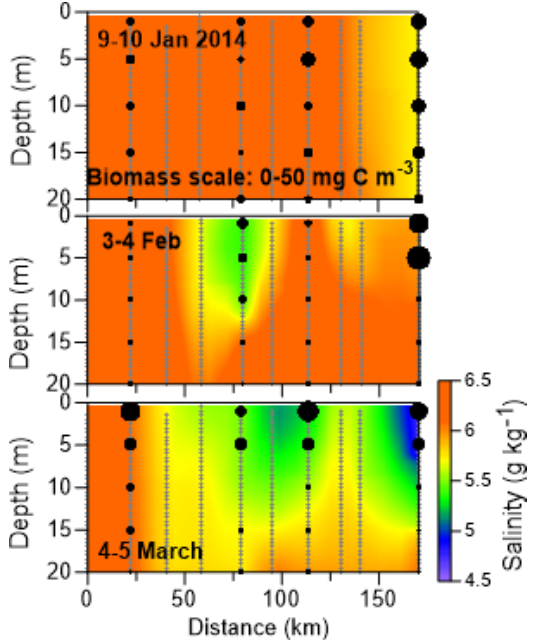
Figure 12. Vertical distributions of salinity (color scale) and phyto- plankton biomass (black dots) along the Gulf of Finland in winter 2014. Phytoplankton biomass (mgCm − 3 ) scale is shown in the up- per panel. Biomass sampling locations are shown in Fig. 1 (blue crosses). Vertical gray lines mark the location of CTD